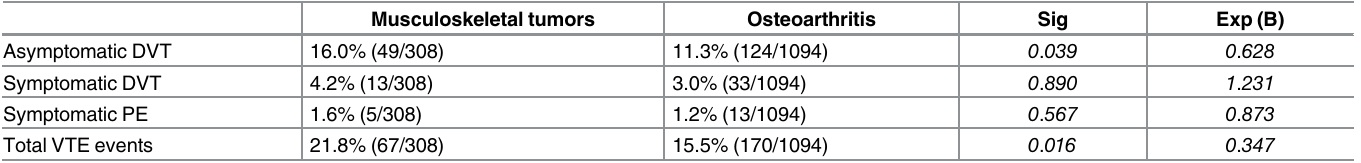
Table 5. Analysis of group as a potential risk factor of VTE with multivariate cox regression analyses. Musculoskeletal tumors